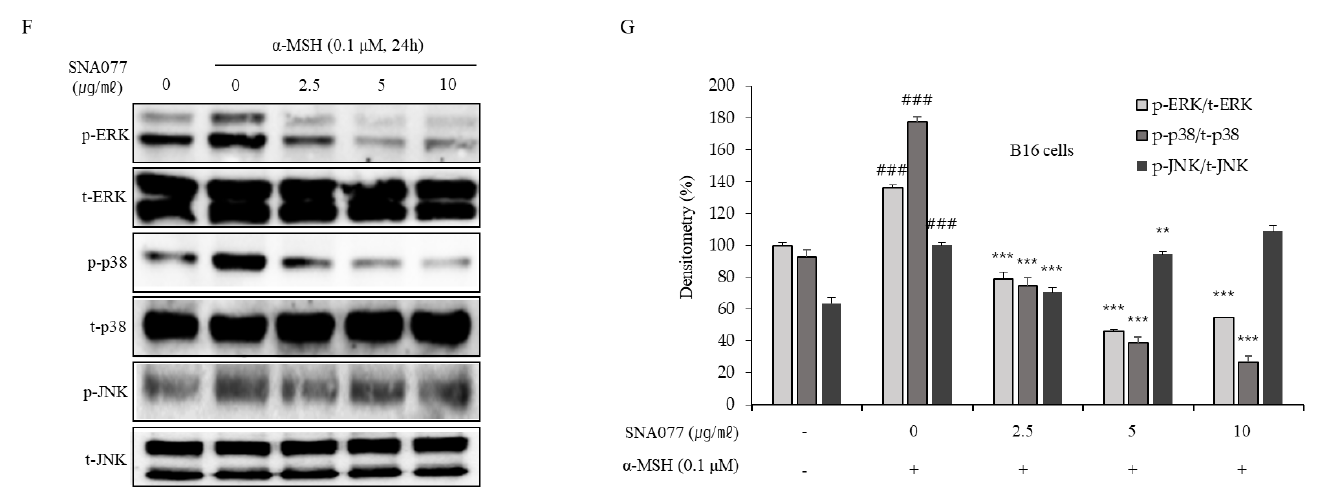
Figure 5. Inhibitory effect of SNA077 on α -MSH-induced cAMP/PKA/CREB and MAPK signaling in B16 cells. ( A , C ) Protein levels of phospho-CREB ( A ) and phospho-PKA substrate ( C ) were determined by Western blot analysis in B16 cells. Cells were treated with SNA077 for the indicated times. Equal amounts of proteins from B16 cells were resolved by 10% SDS-PAGE and detected using specific antibodies. β -Actin was detected as a loading control. ( B ) Protein bands were densitometrically quantified and analyzed using ImageJ software. To study upstream signaling, B16 cells were treated with SNA077 for 15 min and the intracellular cAMP levels in lysates were estimated using a cAMP Parameter assay kit ( D ). ( E ) Based on the cAMP test results, B16 cells were treated with SNA077 for 10 min and mRNA level of MC1R was determined by real-time qPCR analysis. ( F ) Protein levels of phospho-MAPKs were determined by Western blot analysis in B16 cells. Cells were treated with SNA077 for 24 h. Equal amounts of proteins were resolved by 10% SDS-PAGE and detected using specific antibodies; the ratio of each phospho-MAPK to total-MAPK was calculated to control for equal loading. ( G ) Protein bands were densitometrically quantified and analyzed using ImageJ software. Results are presented as means ± SD, expressed as a percentage relative to controls (* p < 0.05, ** p < 0.01, *** p < 0.001 vs. control group; # p < 0.05, ### p < 0.001 vs. the α